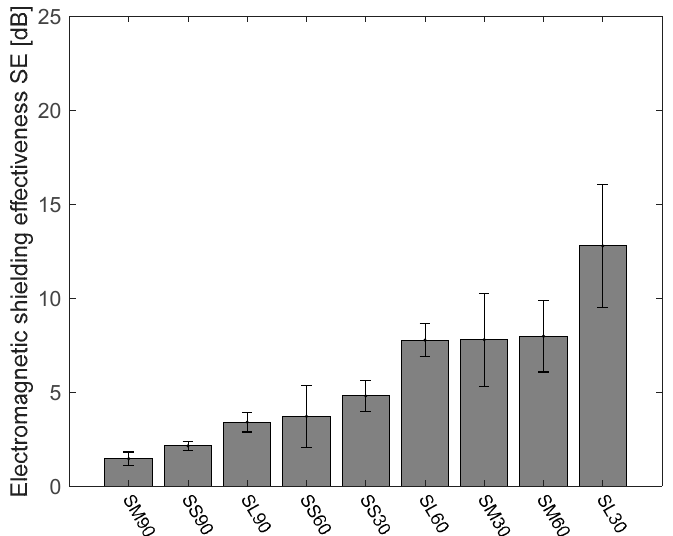
Figure 5. Bar chart of EM SE at 1.5 GHz of the single-layer strip samples with 95% confidence interval of mean.